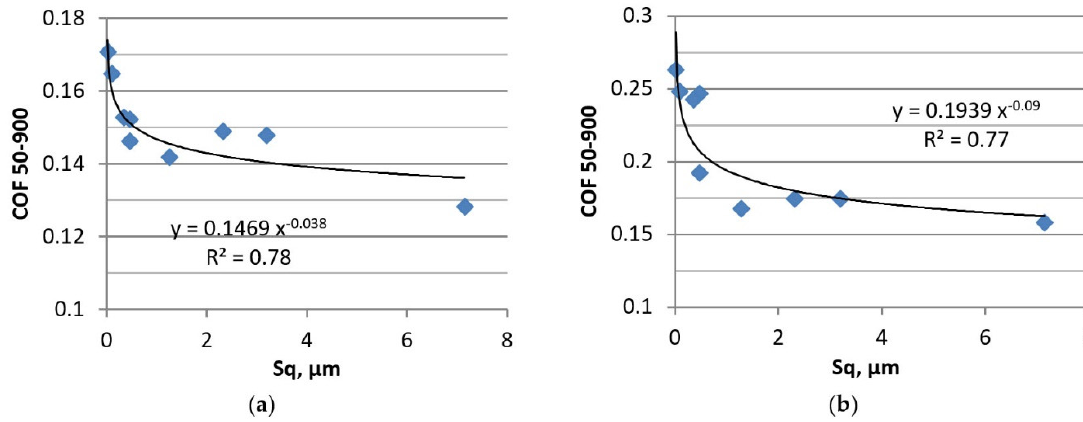
Figure 17. Dependence between the surface height of disc and the coefficient of friction in tests A ( a ) and B ( b ). and B ( b ).